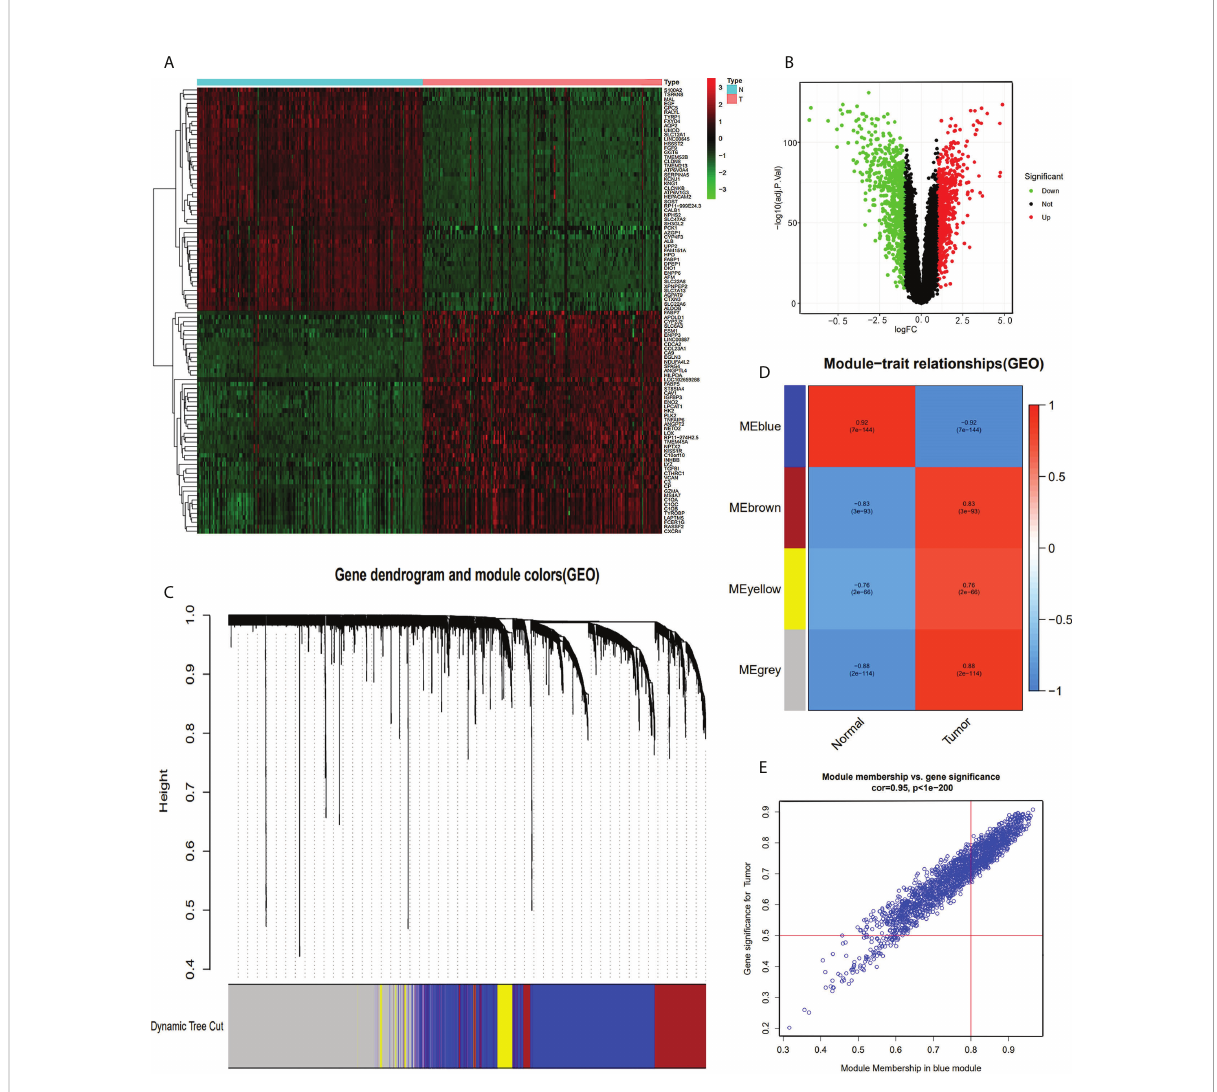
FIGURE 2 DEG and WGCNA analysis of GEO-ccRCC database. (A) Heatmap of top 100 DEGs between ccRCC and normal renal tissue from GEO-ccRCC database. (B) Volcano Plot of 21,653 genes of ccRCC in GEO dataset. Green assigned downregulated genes and rad assigned up. (C) Clustering dendrograms of all the genes of the GEO-ccRCC database, based on the difference in topological overlap, assigned modules with different colors. (D) The four co-expression modules and the module trait between ccRCC and normal renal tissue. (E) Module membership in the blue